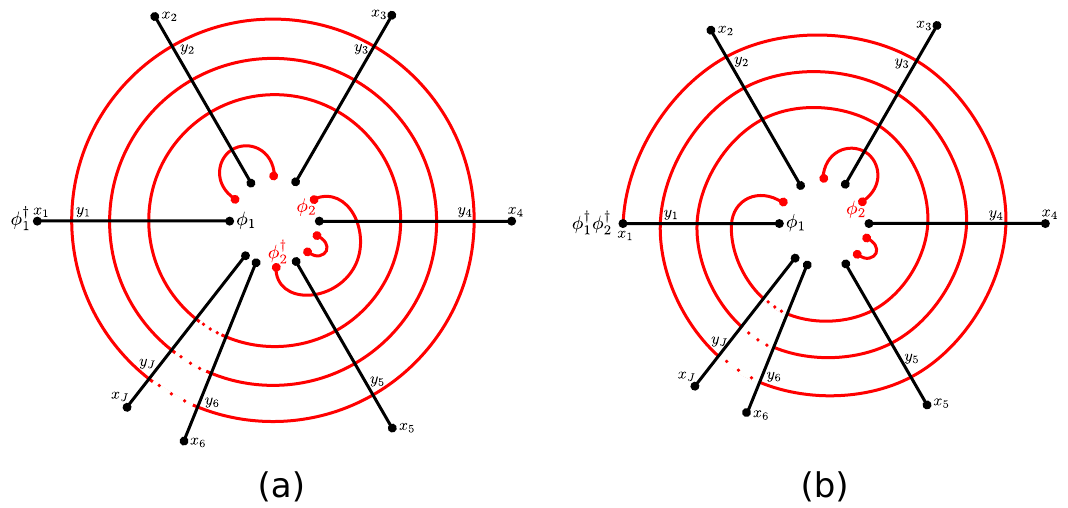
Figure 1 . a) Feynman diagrams that contribute to the correlation function of an operator of the form tr ( @ m (cid:30) J ( (cid:30) 2 (cid:30) y ) n : : : ) are all of (cid:12)shnet type | made of the iterative wheel as shown on 1 2